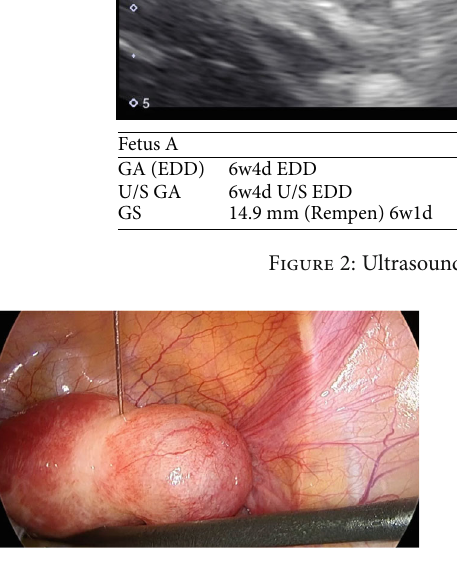
Figure 3: Administration of vasopressin at base of ectopic mass, with good vasoconstrictive e ff ect.